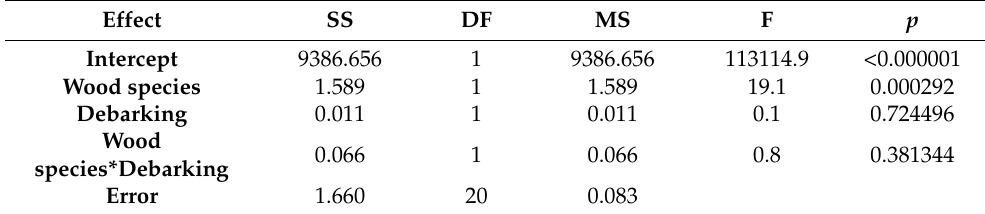
Table A5. ANOVA table for the gross calorific value.